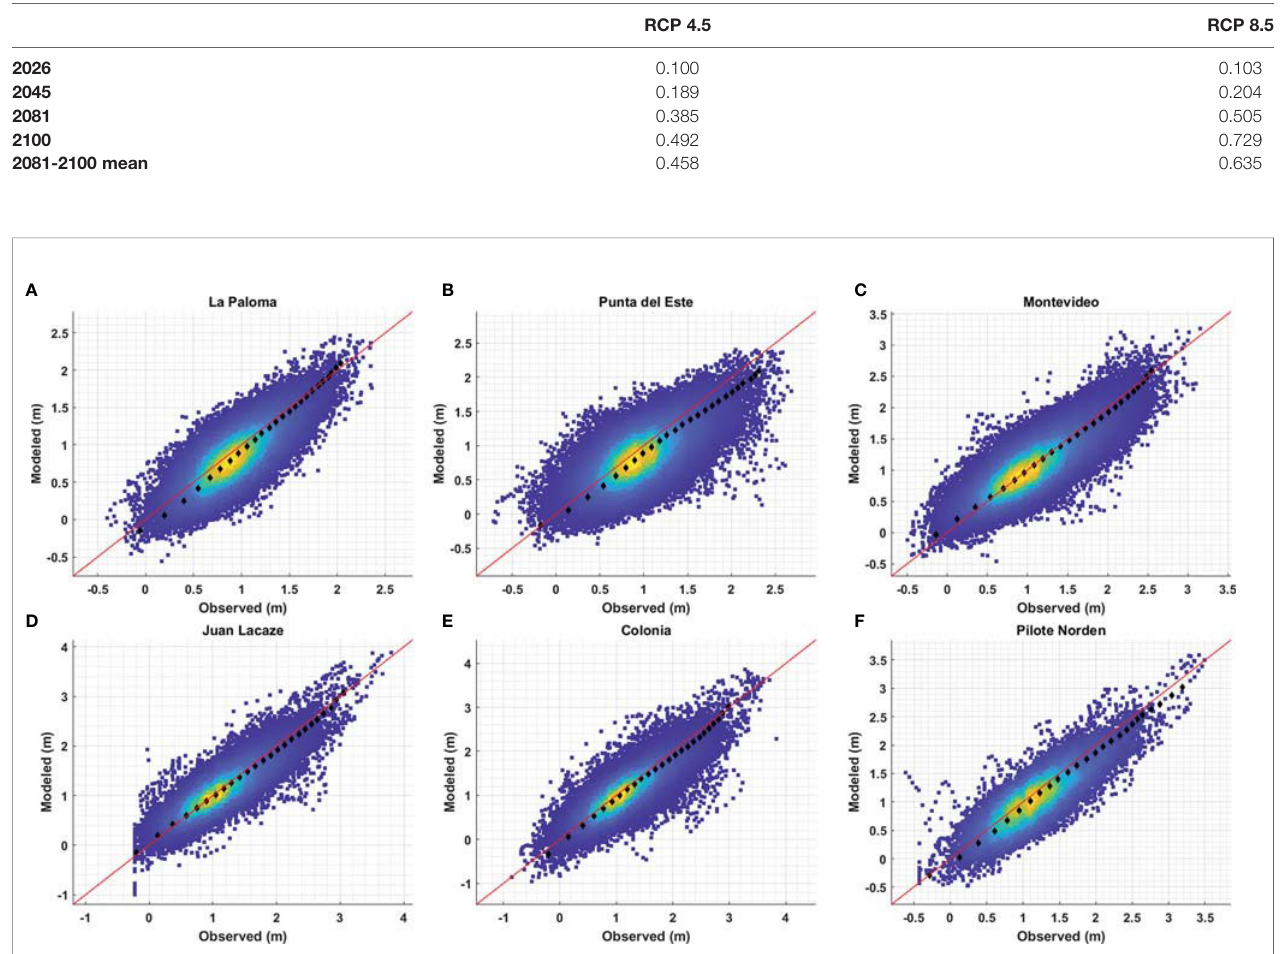
FIGURE 5 | Scatter plot and qq-plot (black) from modeled total sea level (m) vs measured total sea level (m) in: (A) La Paloma, (B) Punta del Este, (C) Montevideo, (D) Juan Lacaze, (E) Colonia and (F) Pilote Norden. Only years with less than 50% hourly missing data considered. Read line represents 1-1 and colorscale represents data density (blue less data – yellow more data). 25 equispaced quantiles shown with Gumbel scale ranging from 0.001 to 0.999.